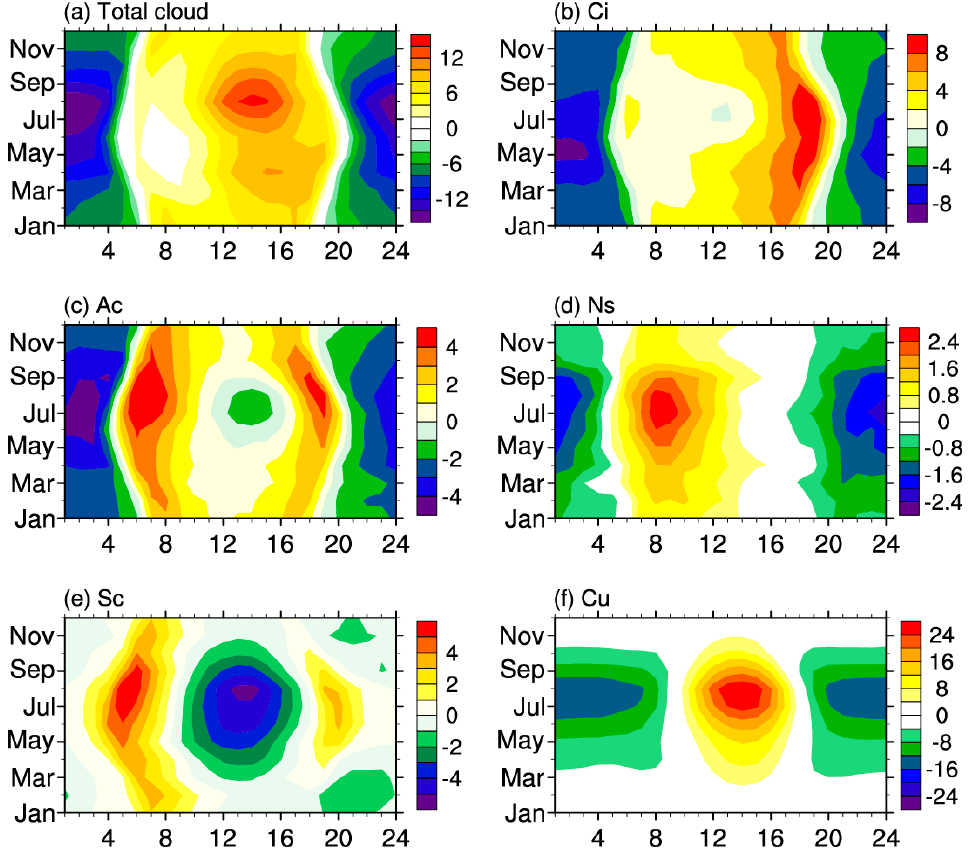
Figure 5. Seasonal variations in the diurnal cycle of anomalous values of the occurrence frequencies of clouds: ( a ) TC, ( b ) Ci, ( c ) Ac, ( d ) Ns, ( e ) Sc, ( f ) Cu (the horizontal axis is the local solar time in hours, and the vertical axis represents the